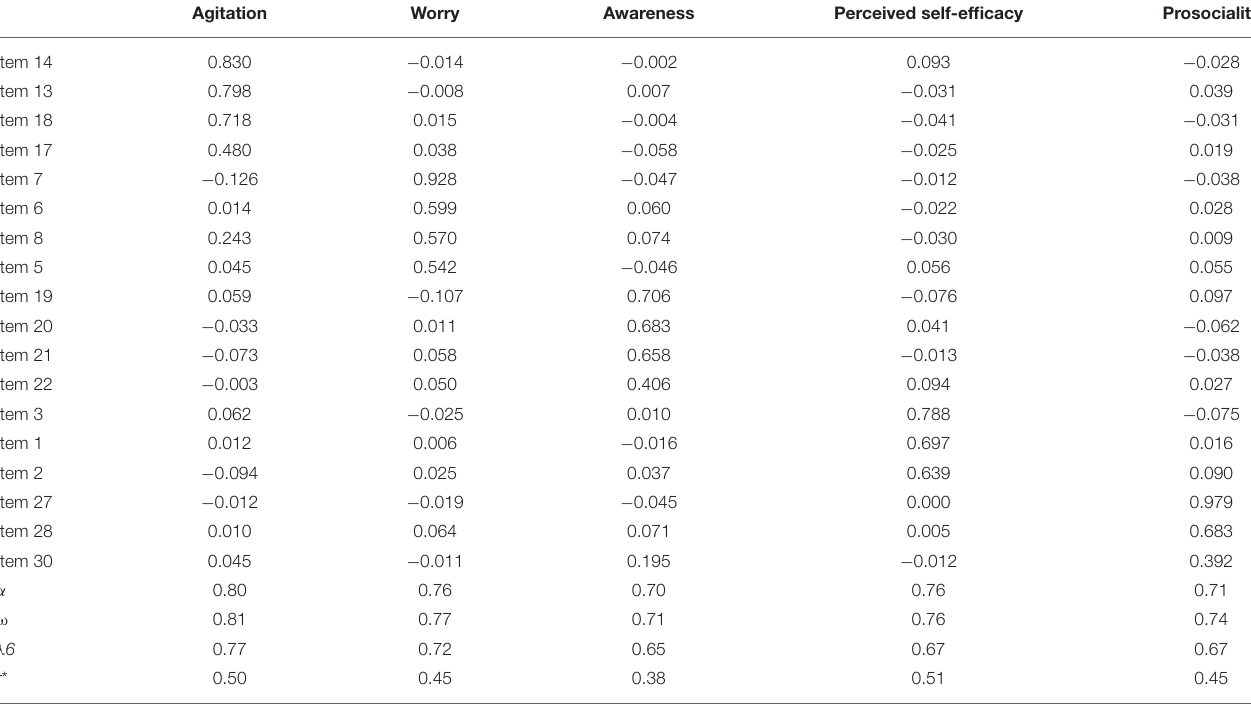
TABLE 3 | Model Matrix (18 items).